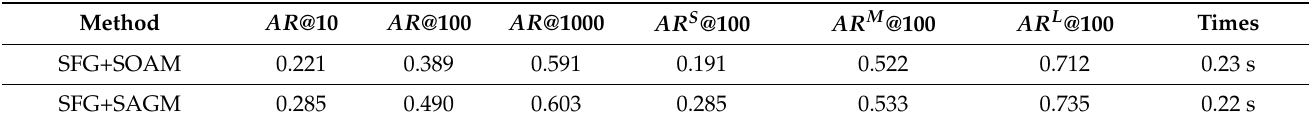
Table 7. Comparison results of the SAGM and the SOAM on the LEVIR data set.